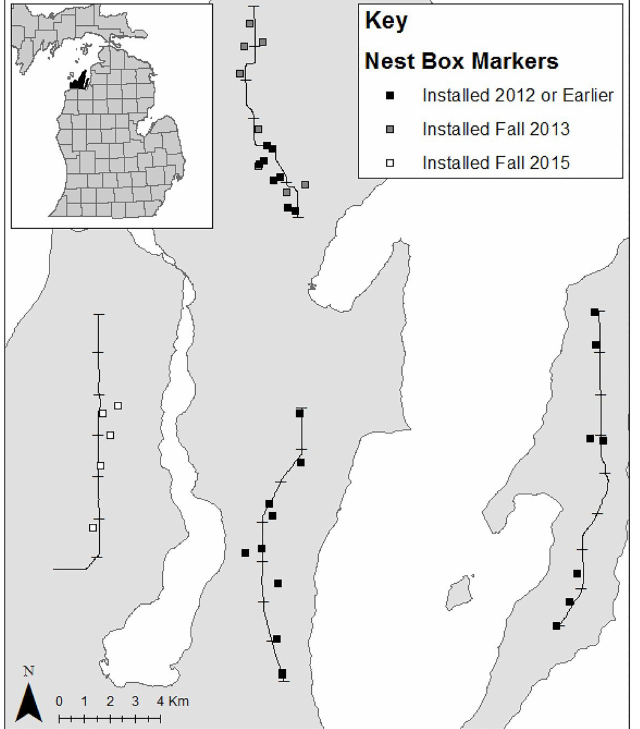
Fig 1. Map of survey sites in the northwestern Michigan study region (Leelanau and Old Mission Peninsulas). Lines indicate the four kestrel survey transects (divided into 28 1.6 km-longsurvey sites); markers indicatenest boxes locatedwithin 0.8 km of either side of transects. Inset: Map of Michiganwith Leelanauand Old Mission Peninsulas shown in black.